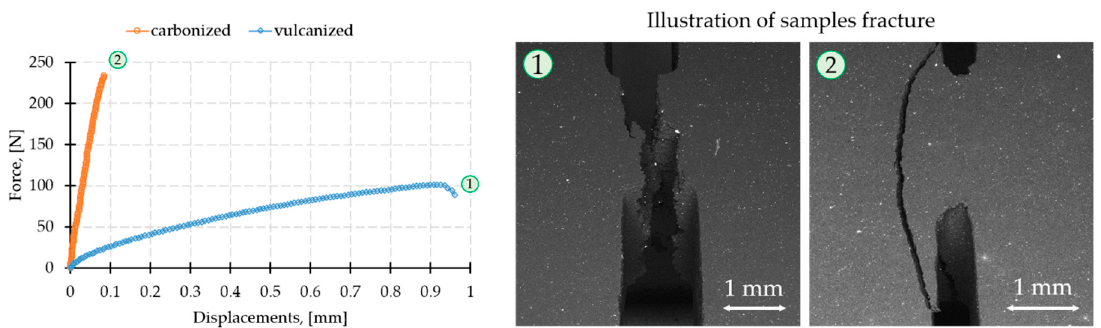
Figure 12. The typical load–displacement curves and fracture appearance for a CEC after vulcanization ( 1 ) and carbonization ( 2 ).